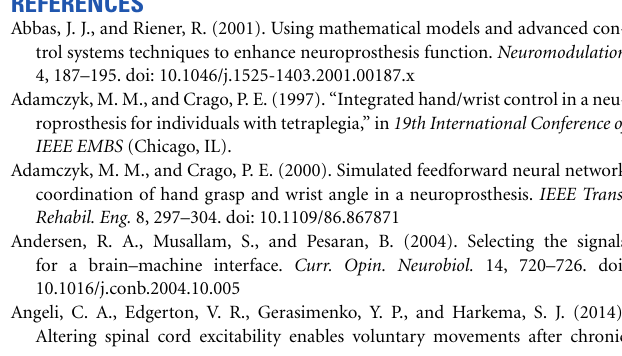
be classified by the controller in order to calculate appropriate stimulation parameters. In turn, these parameters are used by a neural interface to activate spinal circuitry below the level of injury. Figure adapted from Smart Draw LifeART Collection Images and Lobel and Lee